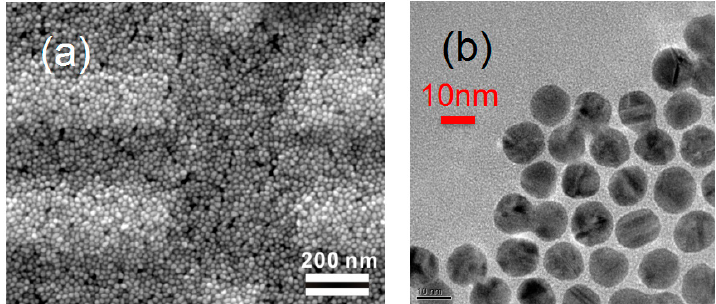
Figure 1. ( a ) the scanning electron micrograph of a 8-mercaptooctanoic acid (MOA) device; rectangles with a light color are the measurement electrodes; ( b ) the transmission electron microscopy image of the synthesized Au nanoparticles deposited on a Si 3 N 4 membrane. Here, the capping molecules are 11-mercaptoundecanoic acid (MUA) molecules. Materials 2017 , 10 , 645